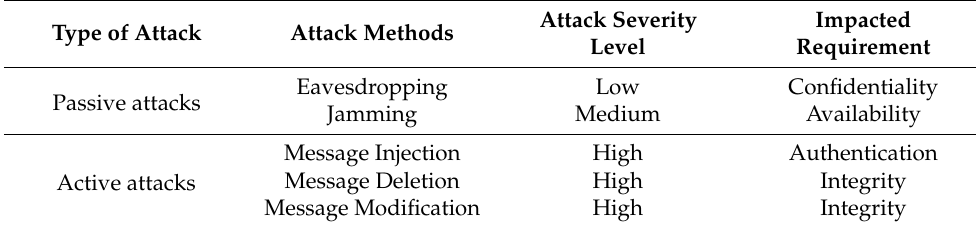
Table 1. ADS-B attack